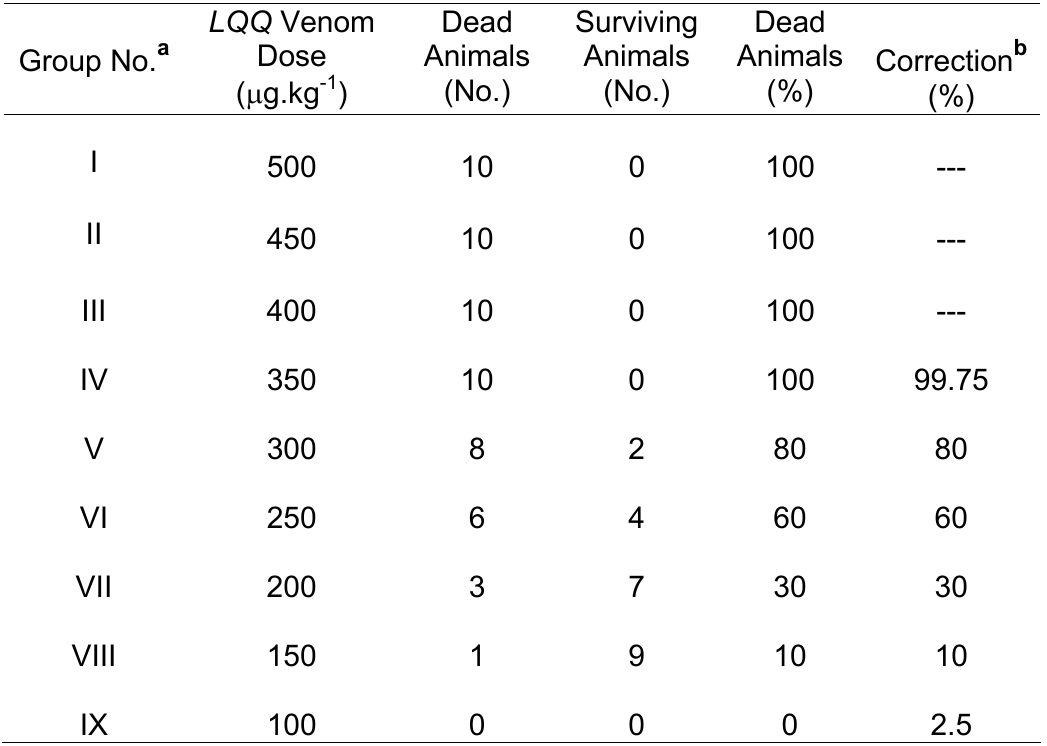
Table 1: Effect of different doses of LQQ venom, injected subcutaneously, on mice